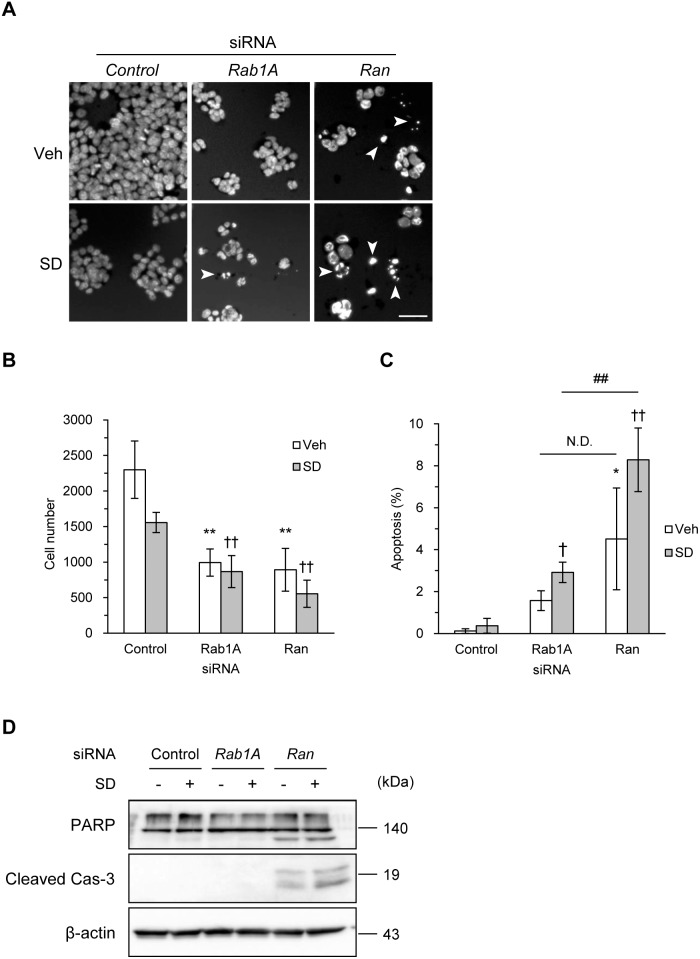
Rab1A knockdown induced cell death not including apoptosis.HT29 cells transfected with Hsc70, Rab1A, Ran, or control siRNA were subjected to serum depletion, 5-FU, or vehicle treatment for 24 h. (A) Rab1A knockdown had little effect on the induction of apoptosis. The induction of apoptosis was analyzed by staining with Hoechst 33258. White arrowheads indicate apoptotic nuclei with condensed chromatin. Scale bar, 50 µm. (B, C) The decrease in cell number by Rab1A knockdown was not due to apoptosis. Numbers of total cells and apoptotic cells were quantified by counting Hoechst-stained cells and cells with nuclear condensation in (A), respectively. *, p<0.05, **, p<0.01 vs. control/veh; †, p<0.05, ††, p<0.01 vs. control/SD; ##, p<0.01 vs. Rab1A/SD by two-way ANOVA followed by Bonferroni/Dunn post hoc test; values are the means ± S.D. (n = 3). (D) Rab1A suppression did not induce apoptosis. Apoptosis was determined by the cleavages of PARP-1 and caspase-3, detected by immunoblotting. β-actin was used as a loading control. Veh, vehicle. SD, serum depletion. FU, 5-fluorouracil. Immunoblotting data are representative of at least three separate experiments yielding similar results.